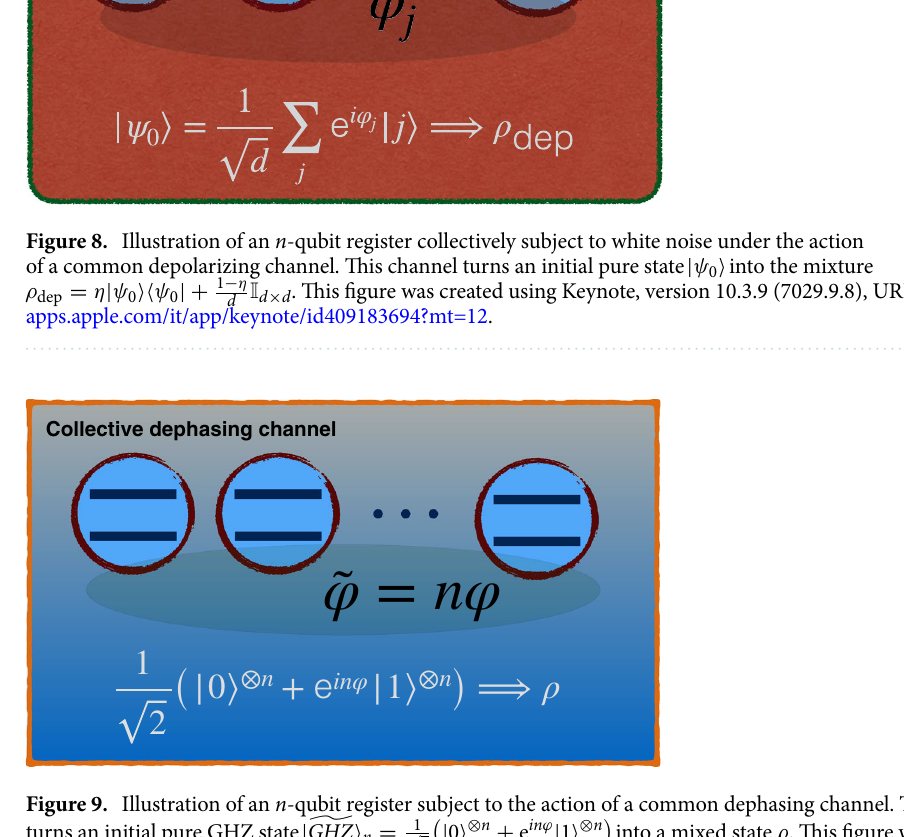
(cid:31) 1 n n GHZ 0 e in ϕ 1 into a mixed state ρ . This figure was created √ 2 | � n = | � ⊗ + | � ⊗ (cid:31) (cid:30)